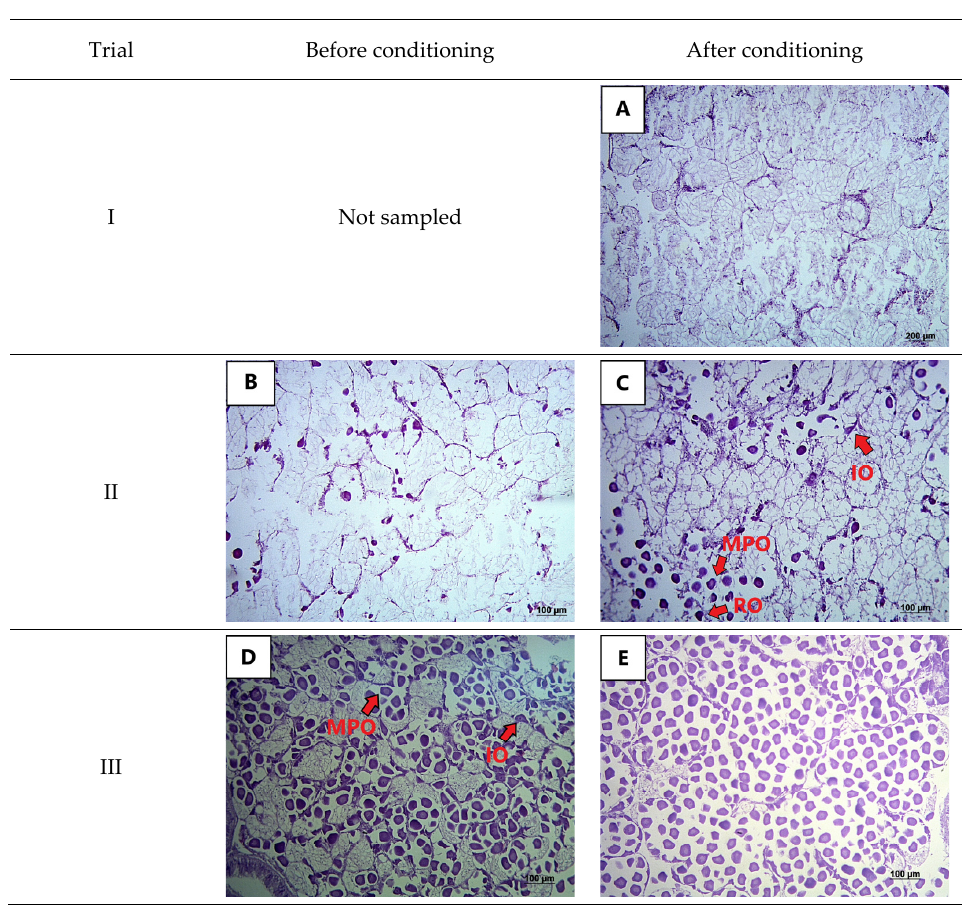
Figure 1. Histological sections of yellow clam ( Amarilladesma mactroides ) before and after the laboratory ‐ conditioning period: ( A ) male gonad of clam from trial I after 14 days of conditioning; ( B ) female gonad with residual (RO) and immature oocytes (IO) characteristic of the spent stage of development; ( C ) female gonad after the conditioning period in trial II showing peduncular ‐ shaped immature oocytes (IO) adhered to the follicle wall; mature, polygonal oocytes (MPO); and residual oocytes (RO); ( D ) stage 3 gonad of female clam at the beginning of trial III where immature oocytes (IO) and mature, polygonal oocytes (MPO) are present; ( E ) female gonad at stage 4 after conditioning in trial III.